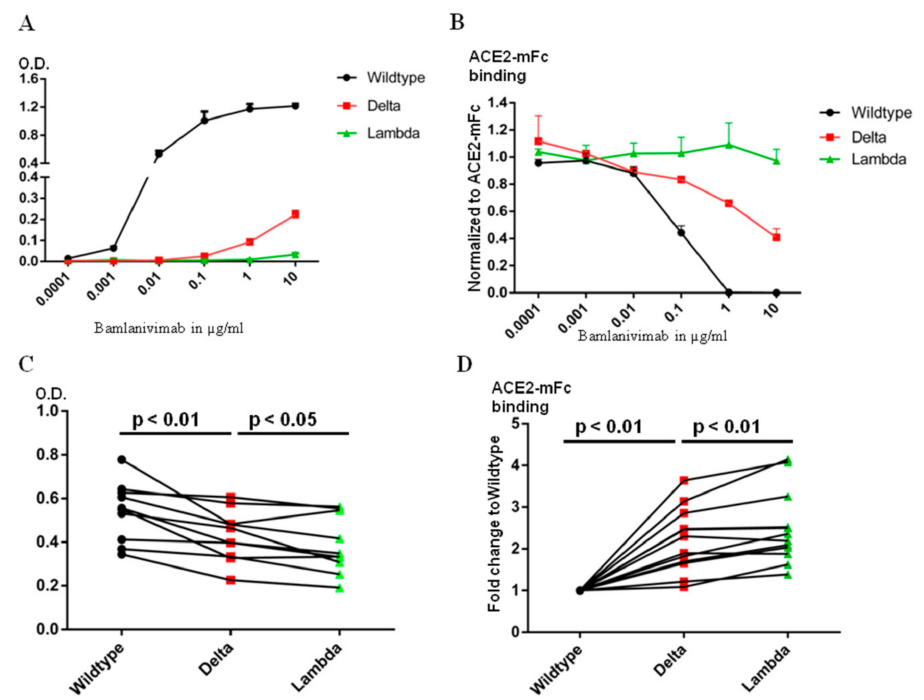
Figure 3. The Lambda RBD evades more Bamlanivimab and serum antibody binding from BNT162b2 mRNA vaccinated donors than Delta. ( A ). ELISA detection of Bamlanivimab binding to wild type, Delta or Lambda RBD coated plate. ( B ). ELISA detection of Bamlanivimab blocking efficacy of ACE2-mFc interaction with wild type, Delta or Lambda RBD. ( C ). BNT162b2 mRNA vaccinated sera from 10 donors were assayed on wild type, Delta or Lambda RBD coated ELISA plate to compare serum antibody evasion. The O.D. values of serum from the same donor on wild type, Delta or Lambda are linked with lines. ( D ). ELISA detection of serum antibody from 12 donors in blocking ACE2-mFc interaction with wild type, Delta or Lambda RBD. The black, red and green symbols in Figure C and D indicate signal from wild type, Delta and Lambda RBD